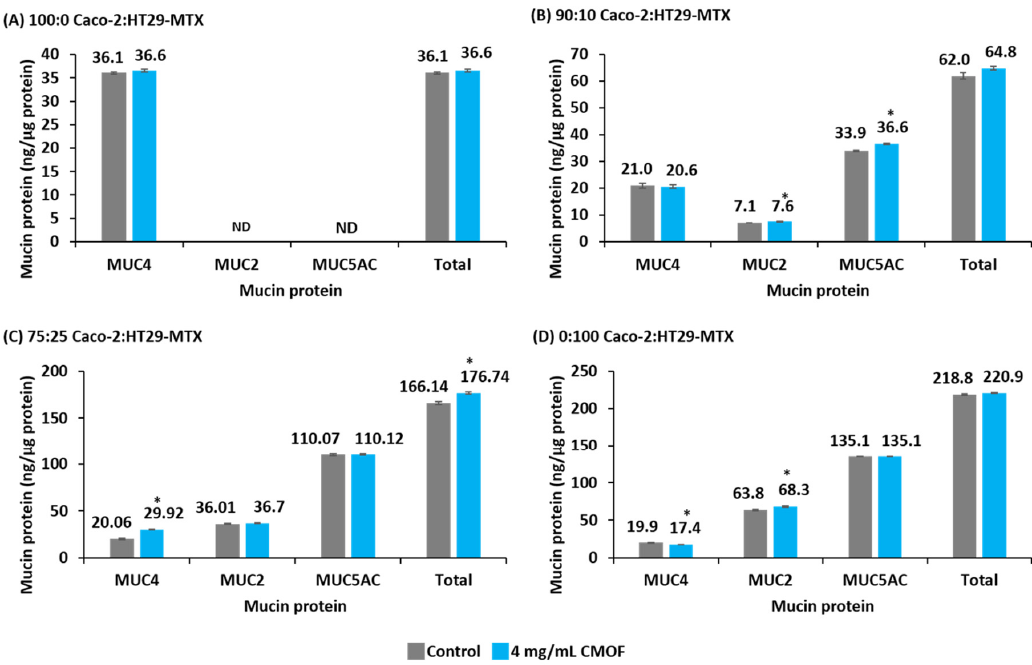
Figure 4. The abundance of the individual mucin proteins (MUC4, MUC2 and MUC5AC) and the total mucin protein abundance from post-confluent (21 days post-seeding) control Caco-2:HT29-MTX mono- and co-cultures (ng/ µ g total protein) and those incubated with 4.0 mg/mL caprine milk oligosaccharide-enriched fraction (CMOF) for 12 h. Results are expressed as the mean abundance (ng/ µ g of total protein) (±SEM). * p < 0.05 compared to respective control.